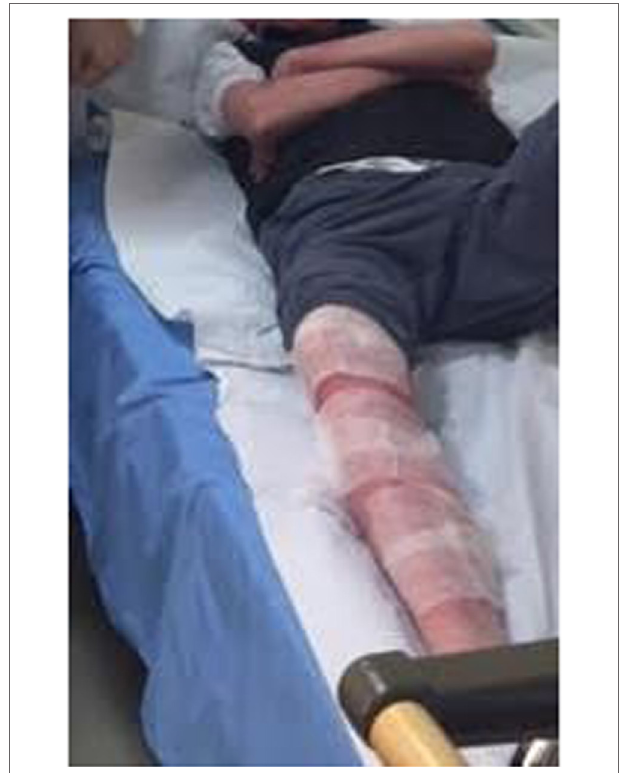
FIgURe 1 | Local application of phage using gauze and liquid phage preparations.